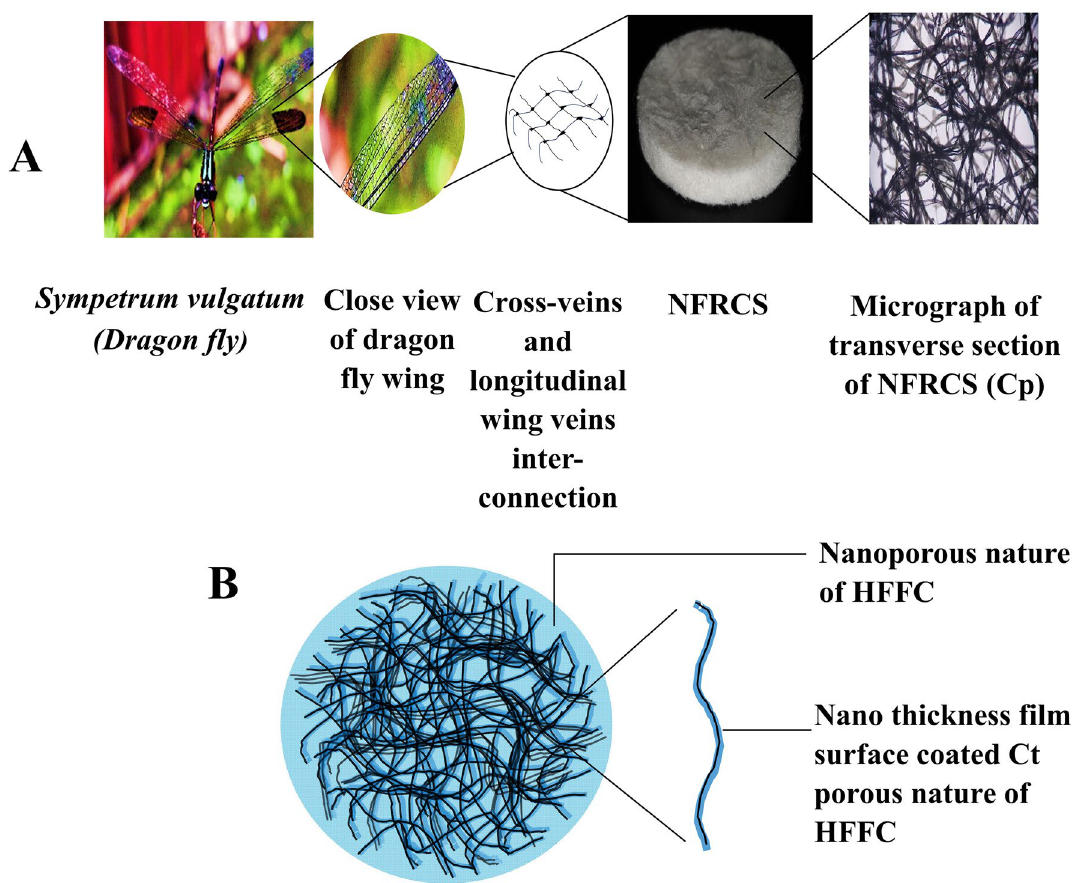
Figure 1. The image represents the schematic representation of NFRCS structural design based on dragonfly wing structure, ( A ). The image shows the comparative analogy of the dragonfly wing structure (cross vein and longitudinal wing veins interconnection) and micrograph of a transverse section of Cp NFRCS, ( B ). Schematic representation of